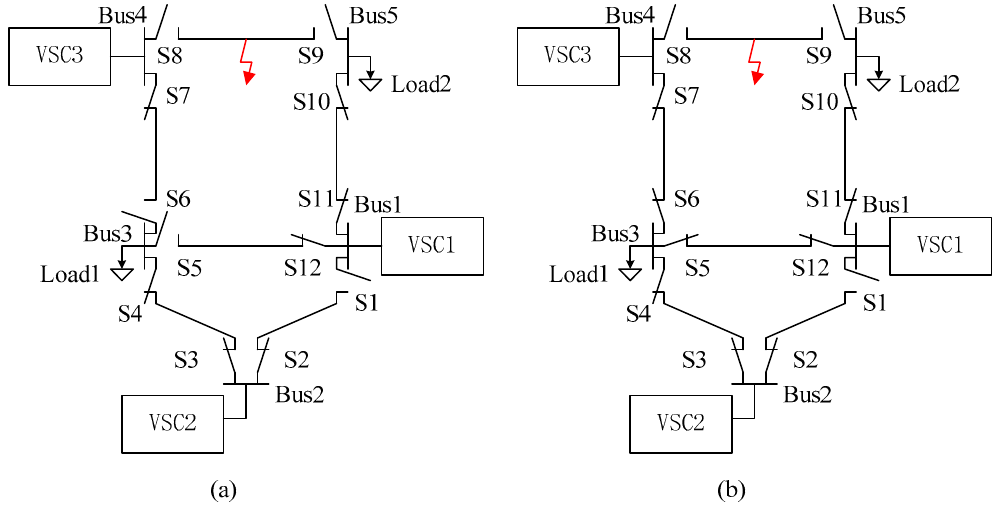
Figure 10. Switch operations of the improved handshaking method: ( a ) Switches state after step 2; ( b ) Switches state after step 4.